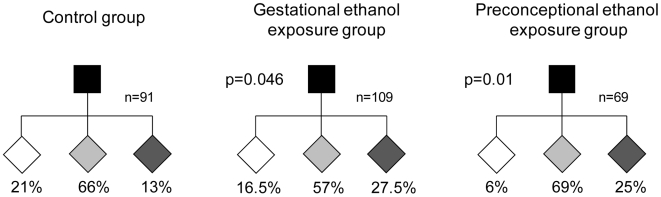
Gestational and preconceptional ethanol exposure produced a higher proportion of pseudoagouti Avy mice.In each pedigree, the black square represents the a/a dam and the diamonds represent her Avy/a offspring. Avy/a sires and all a/a offspring have been excluded from the pedigrees. White diamonds represent yellow offspring, light gray diamonds represent mottled offspring and dark gray diamonds represent pseudoagouti offspring. The percentage of offspring in each coat color category is indicated. The gestational ethanol exposure group and the preconceptional ethanol exposure group were statistically significantly different to the control group using Pearson's chi-square test (p<0.05).